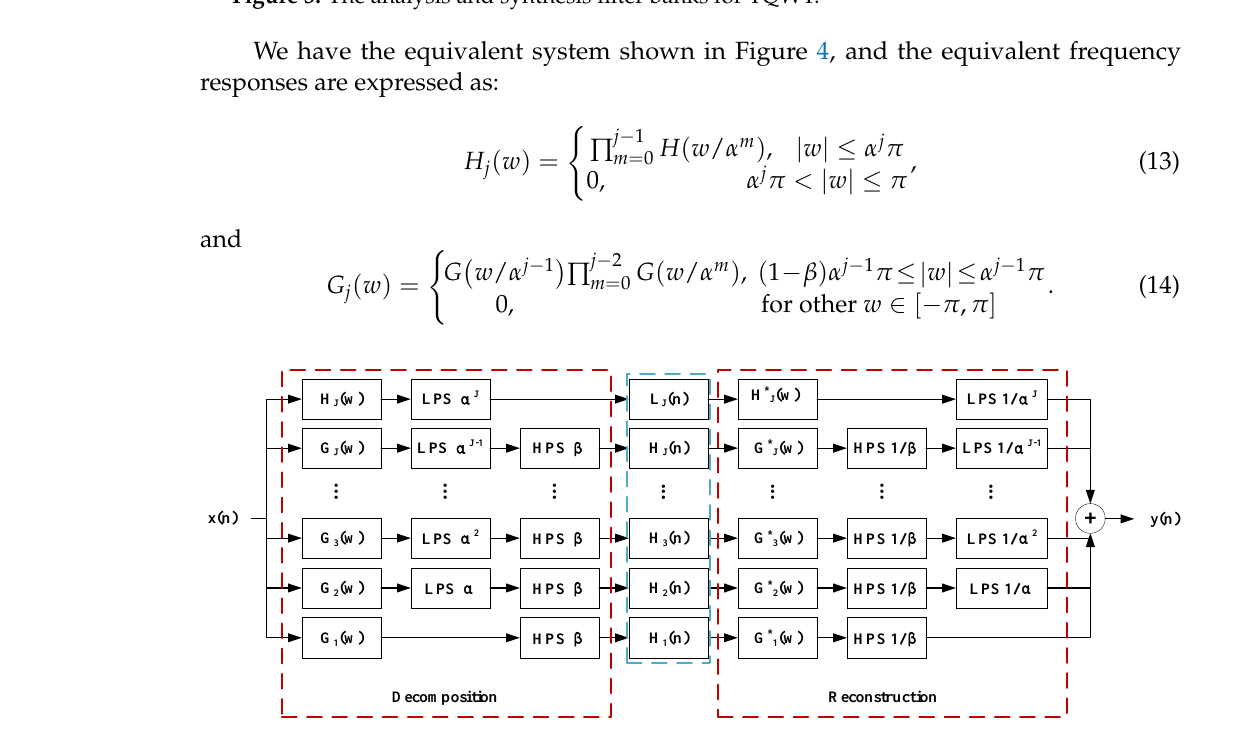
Figure 4. The equivalent filter banks for